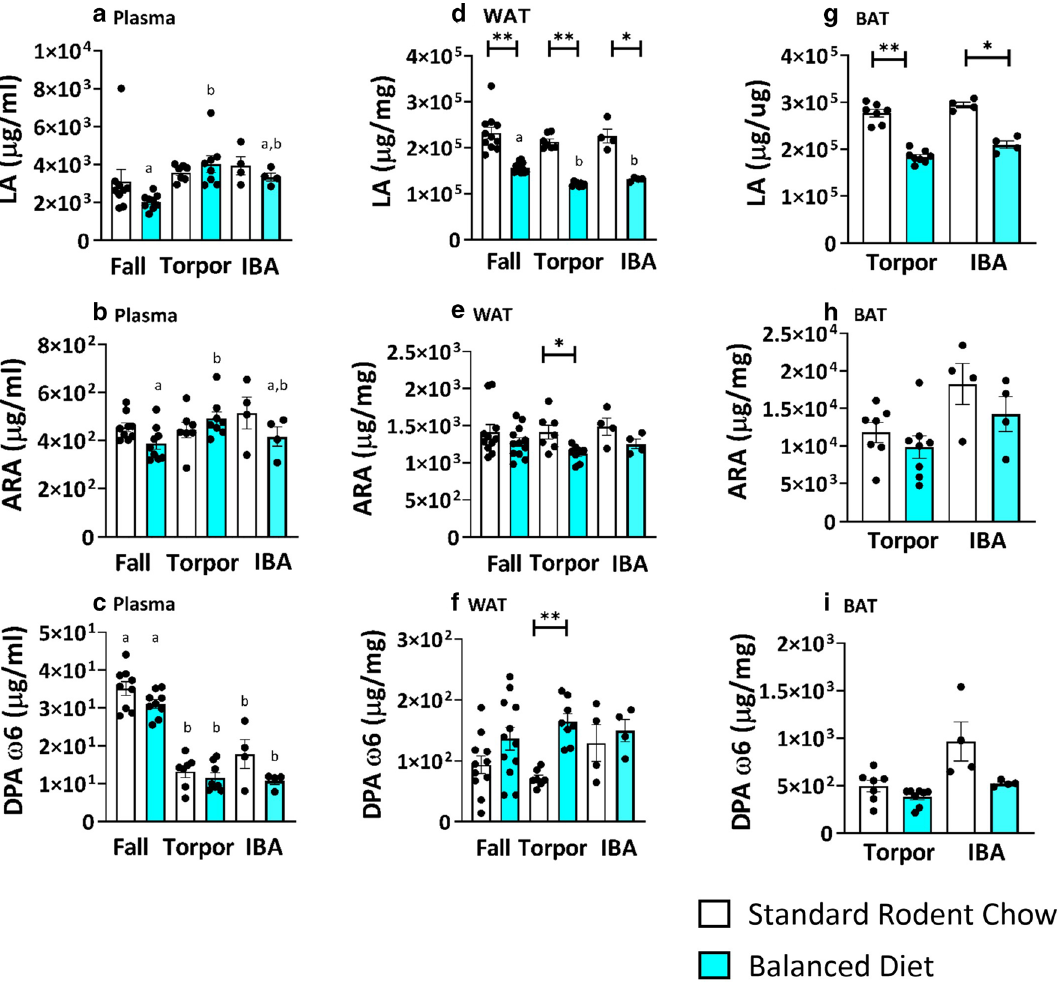
Figure 4. Balanced Diet does not influence omega 6 PUFAs in plasma, but diet influences LA in WAT and BAT. ( a ) Plasma LA, ARA and DPA w3 does not differ between Balanced Diet (BD) AGS in all time points compared to Standard Rodent Chow (SRC) AGS (t-test, FDR corrected, fall n = 9, torpor n = 7–8, IBA n = 4). Seasonal comparison within the same diet found plasma LA increases in torpor compared to fall BD AGS while DPA w6 decreases in torpor and IBA compared to fall in both diets (post hoc Tukey, letters (a or b) signify difference between season within the same diet group). ( b ) WAT LA is increased in SRC AGS compared to BD AGS in fall, torpor and IBA, while ARA is increased in torpid SRC animals and DPA w6 is increased in BD AGS in torpor (*p < 0.05, **p < 0.001, t-test, FDR corrected, fall n = 11–12, torpor = 7–8, IBA = 4). Seasonal comparison within the same diet found WAT LA decreases in torpor compared to fall BD AGS (post hoc Tukey, letters (a or b) signify difference between season within the same diet group) c. BAT LA is significantly higher in SRC AGS compared to BD AGS in torpor and IBA (*p < 0.05, **p < 0.001, t-test, FDR corrected, torpor = 7–8, IBA = 4). Data shown are mean ± SEM. Black dots are individual data